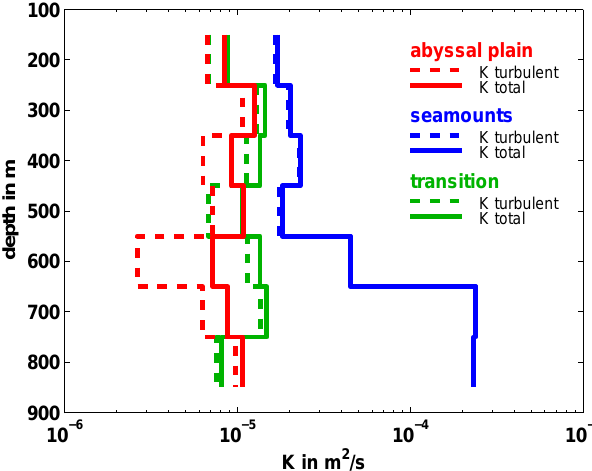
Figure 11. Profiles of the diapycnal eddy diffusivity as estimated from microstructure measurements (dashed lines) and by account- ing for the effect of double diffusion (solid lines) for different re- gions: (red) abyssal plain, (blue) seamount region, and (green) tran- sition region.